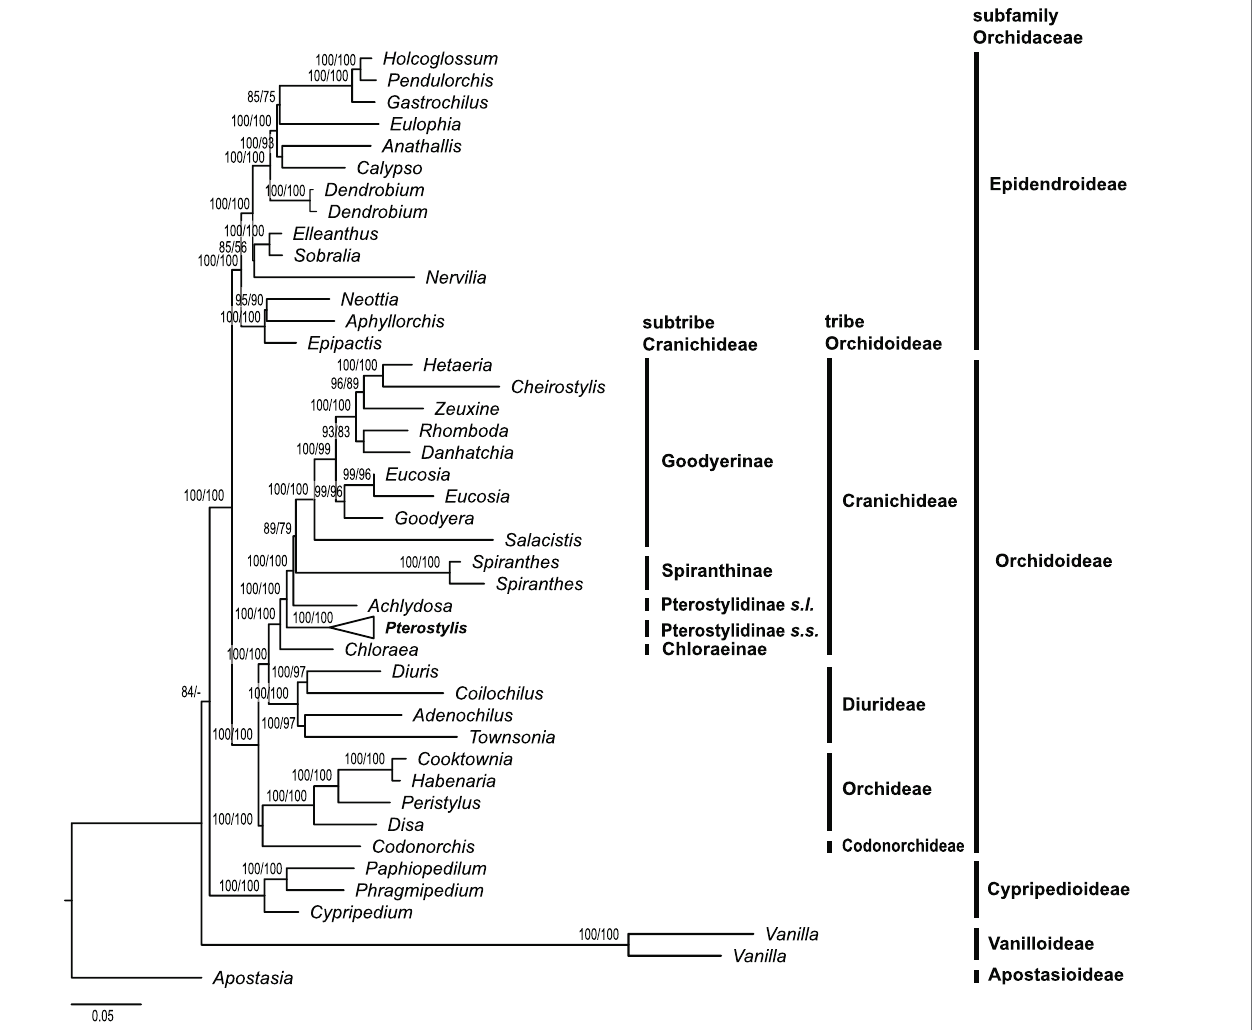
FIGURE 3 | Higher-level phylogenetic relationships in Orchidaceae and placement of Pterostylidinae within Cranichideae. Maximum likelihood reconstruction based on 75 plastid genes (91,090 bp alignment) with IQ-TREE. Nodal support values >50 are given above branches (ultrafast bootstrap values from IQ-TREE analysis followed by bootstrap values from RAxML